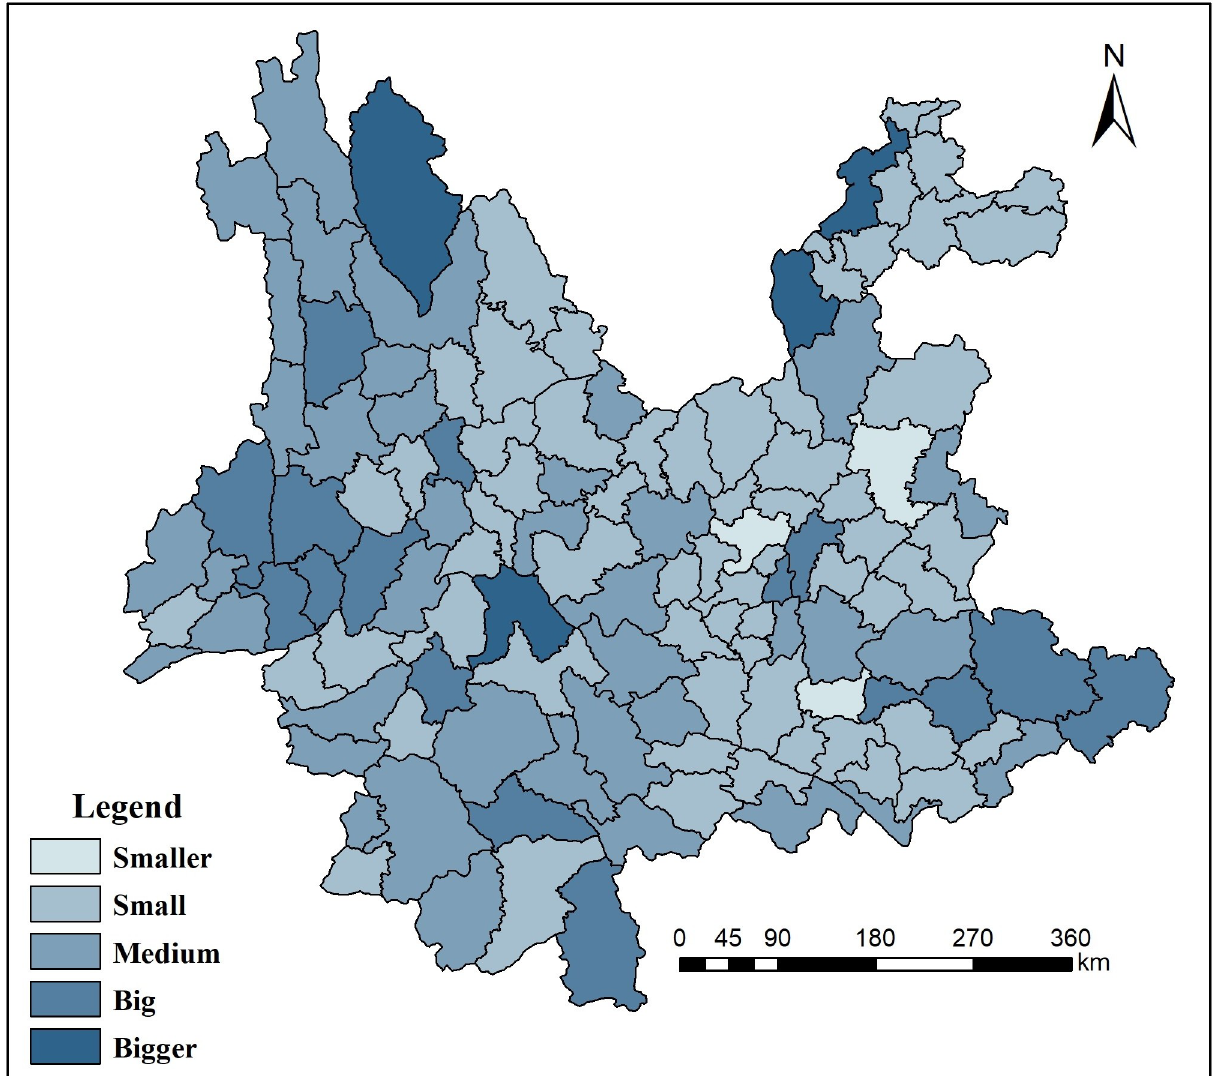
Fig 2. Spatial differentiation of the water environmental capacity in Yunnan